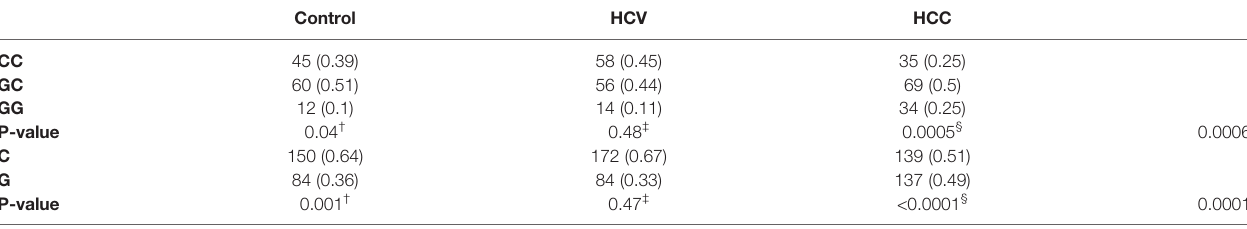
TABLE 3 | Frequency distribution for genotypes and alleles for EpCAM rs62139665 in patients and control